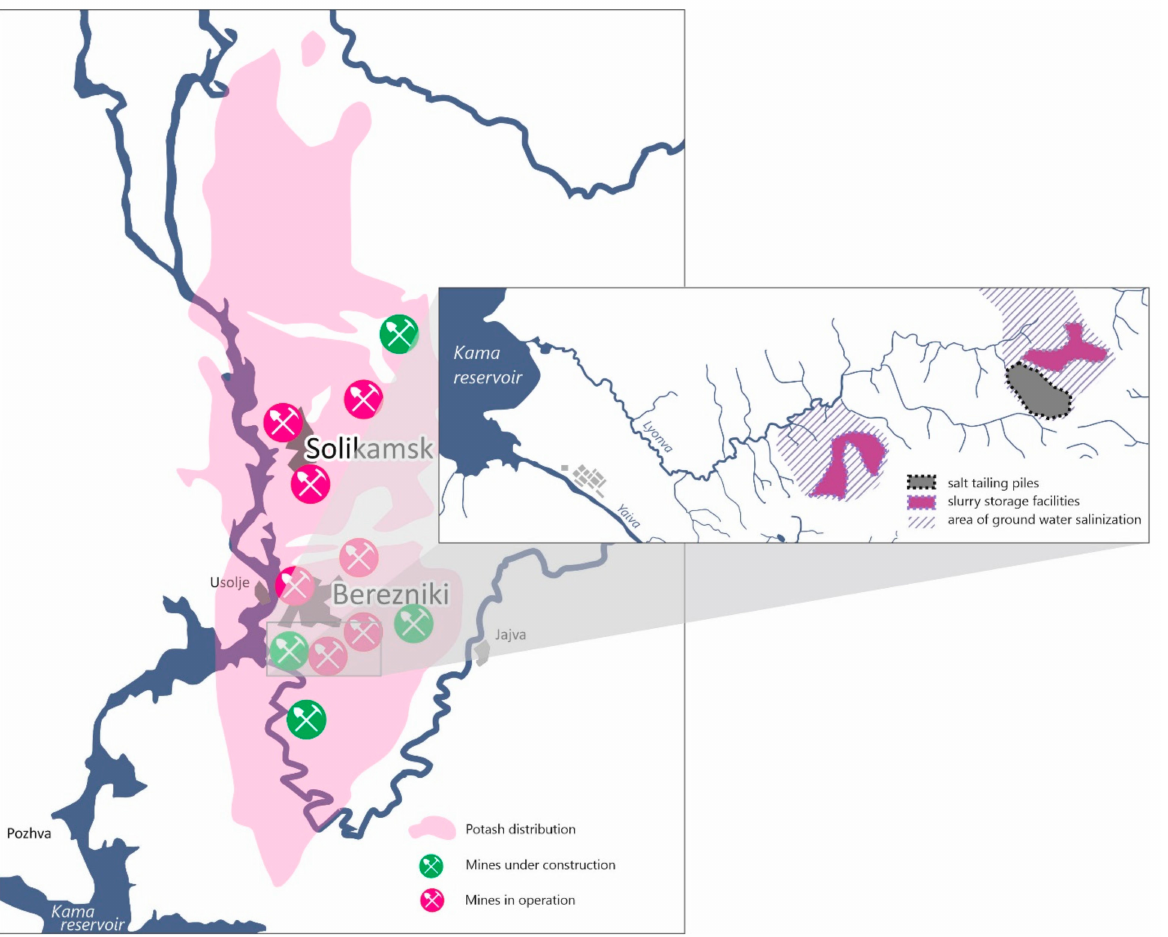
Figure 3. Scheme of the Verkhnekamskoe Potash deposit and research